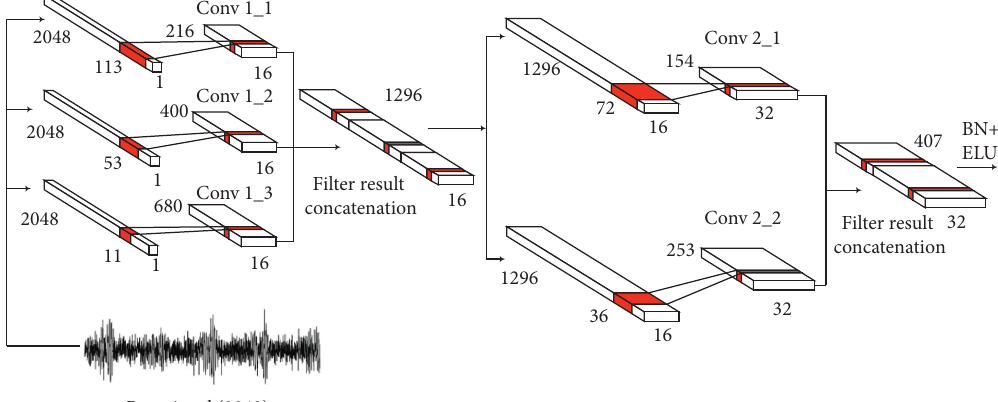
Figure 1: Multiscale convolutional